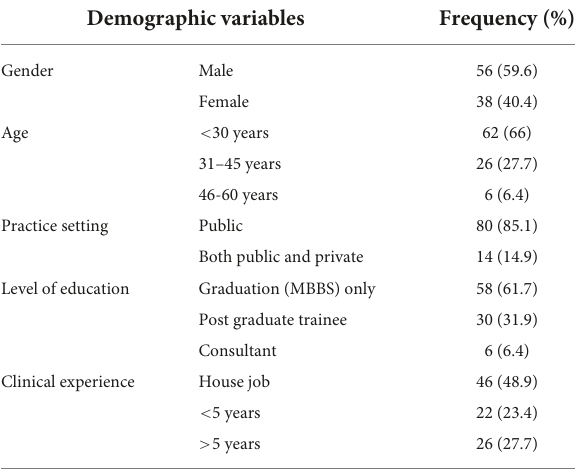
TABLE 1 Demographics of physicians under